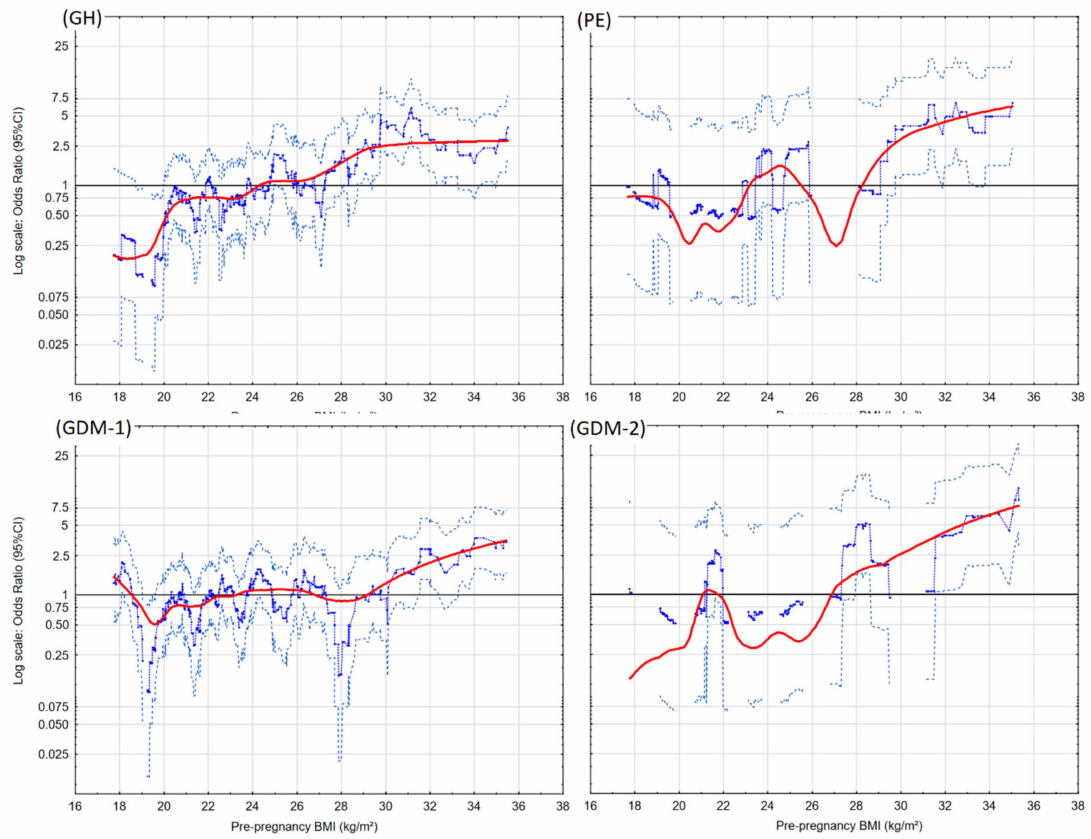
Figure 1. The risk profiles of hypertension in pregnancy (gestational hypertension (GH) and preeclampsia (PE)) and diabetes in pregnancy (gestational diabetes with dietary modification (GDM-1) and gestational diabetes with insulin therapy (GDM-2)), for pre-pregnancy body mass index (BMI). The graphs illustrate the changes in the crude risk (OR) of the diseases, estimated on a sliding window (for 30 observations) with respect to the BMI values. The blue points are the odds ratios of the diseases in the adopted window. The curves represent the risk profiles (the curves are smoothed with the Lowess method). The horizontal lines represent OR = 1.00. The light gray points represent the upper and lower limits of the 95% confidence intervals